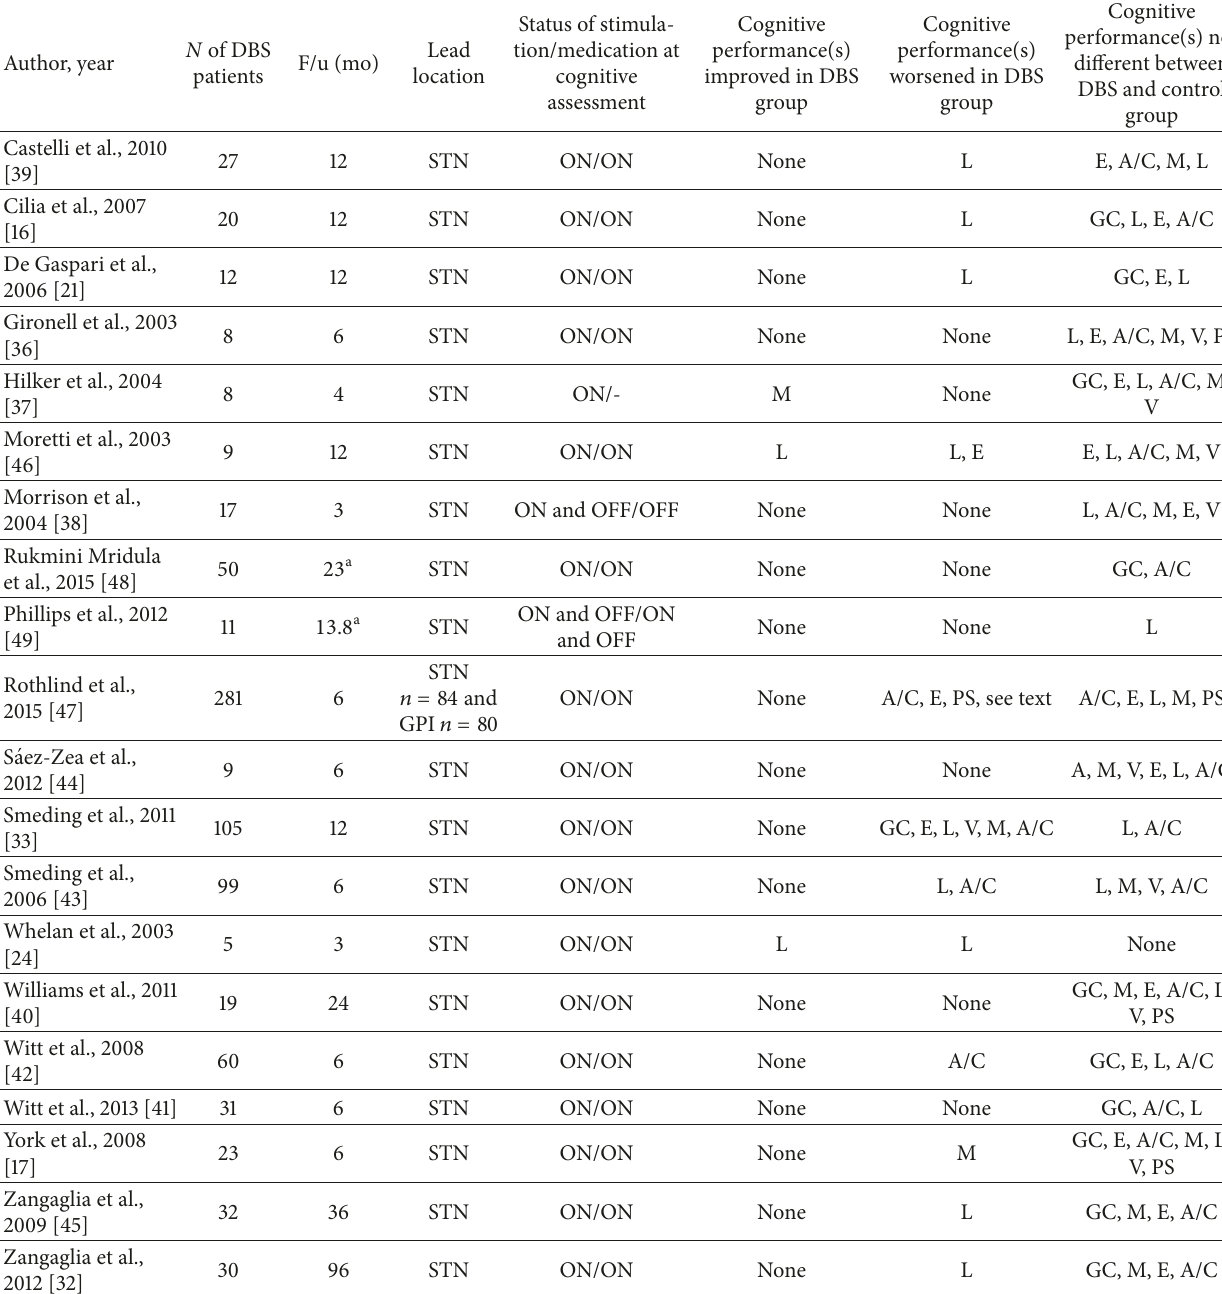
Table 3: Controlled studies assessing cognitive change in PD patients after